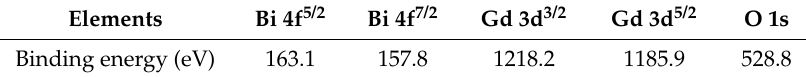
Table 2. Binding energies of Bi 4f, Gd 3d and O 1s in BiGdO 3 .